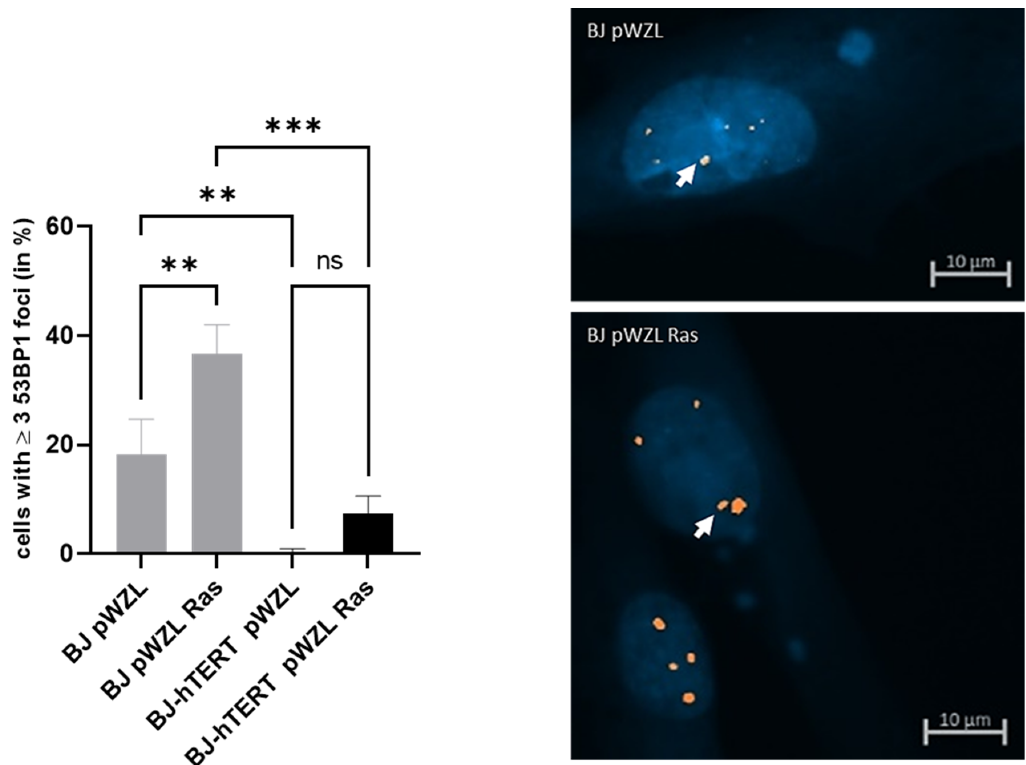
Figure 7. Evaluation of 53BP1 foci formation upon oncogene-induced replication stress. ( Left ) The bar plot displays the impact of ectopic H-RAS G12V on 53BP1 foci formation in BJ and BJ-hTERT cells. pWZL represents the empty vector control. One-way ANOVA test was applied, followed by a Fisher’s LSD post hoc test, with a confidence interval of 95%. ( Right ) Representative images of BJ-pWZL (top) and BJ pWZL-RAS (bottom). A total of 200 cells were counted from n = 5 independent experiments. The representative pictures show DAPI-stained nuclei with nuclear pRPA2 foci (white arrow). ns ( p > 0.05), ** ( p ≤ 0.01), *** ( p ≤ 0.001).